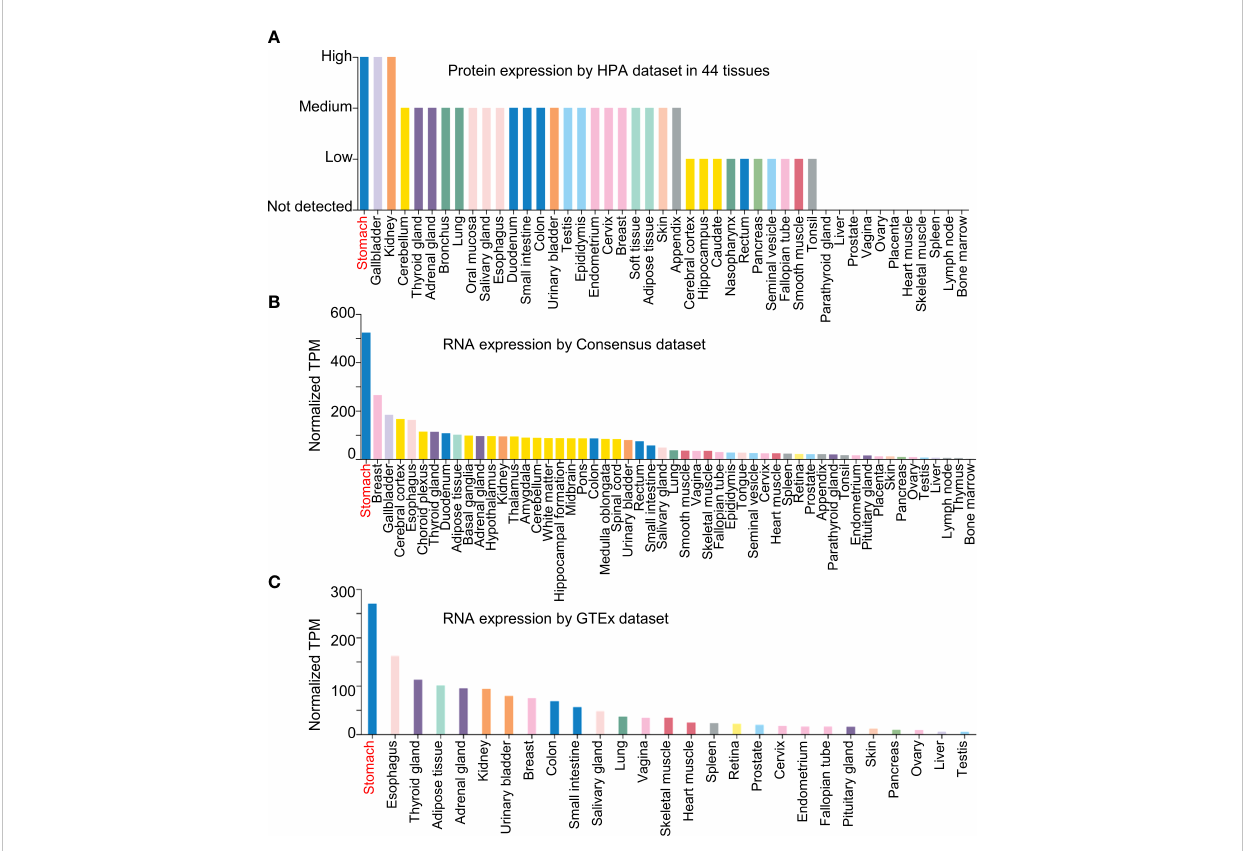
FIGURE 1 NQO1 is a speci fi c gene expressed in gastric tissues. (A) The NQO1 protein expression level was assessed using Human Protein Atlas dataset in 44 tissues. (B, C) The NQO1 transcript level was conducted in Consensus dataset and GTEx